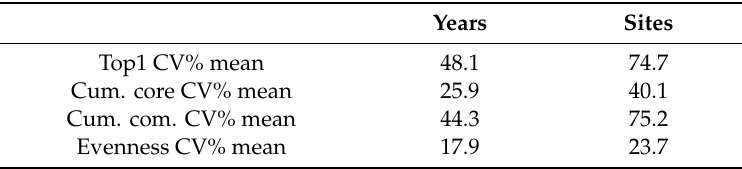
Figure A2. Picture of the deployed reed island. Table A1. Mean coe ffi cients of variation (CV %) of cumulative core and common species abundance and evenness, across sites and over years in the Á sv á ny and Cikola branch